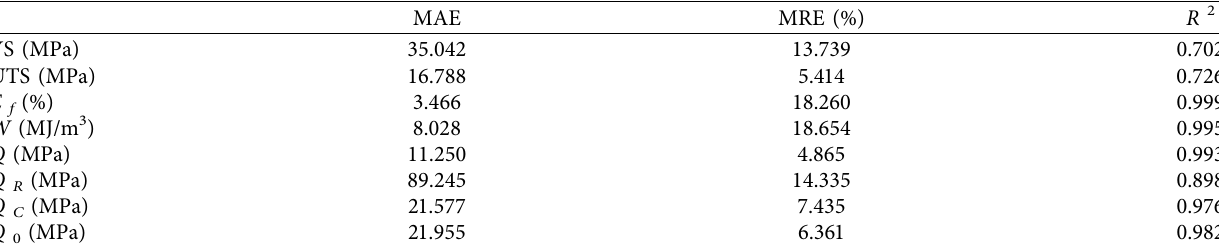
Table 3: CV result of the multiple quadratic regression models for tensile mechanical properties and quality indices of A357.